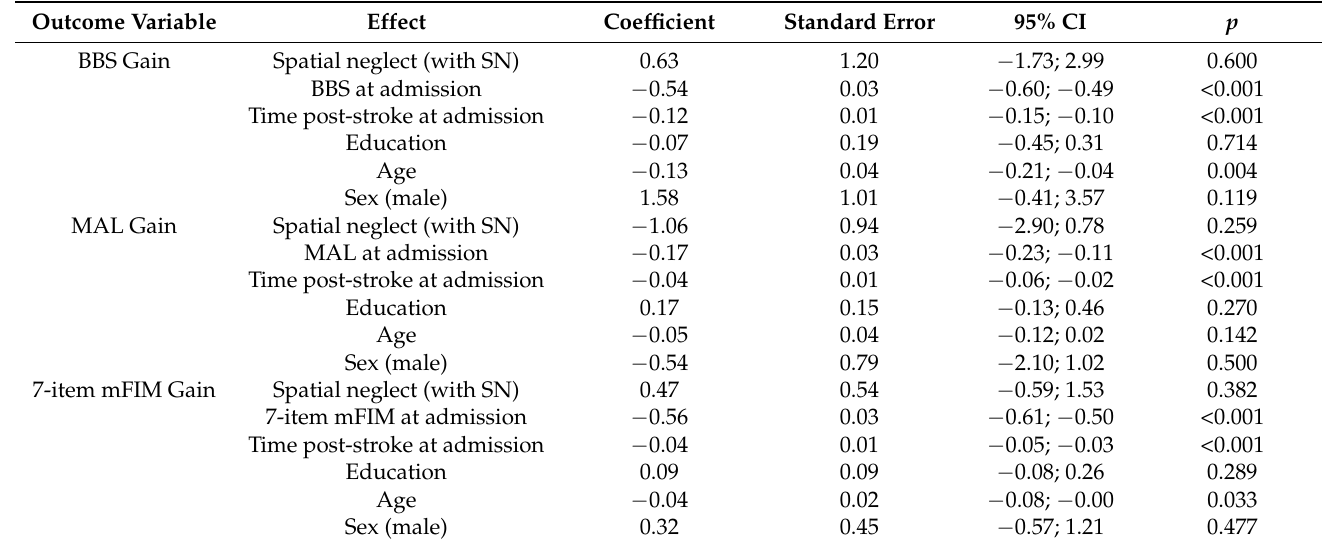
Table 3. Parameter estimates of the GLM (patients with SN vs. patients without SN).